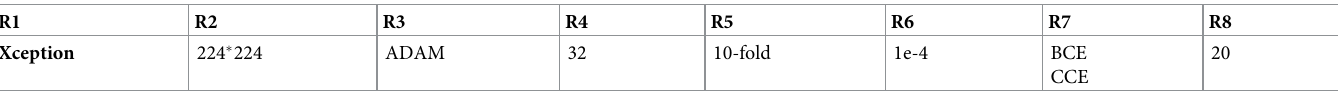
R1—Model, R2—Image Size, R3—Optimizers, R4—Mini Batch Size, R5—cross validation, R6—Initial Learning Rate, R7—Loss function, R8—Epoch, BCE—Binary cross-entropy, CCE—Categorical